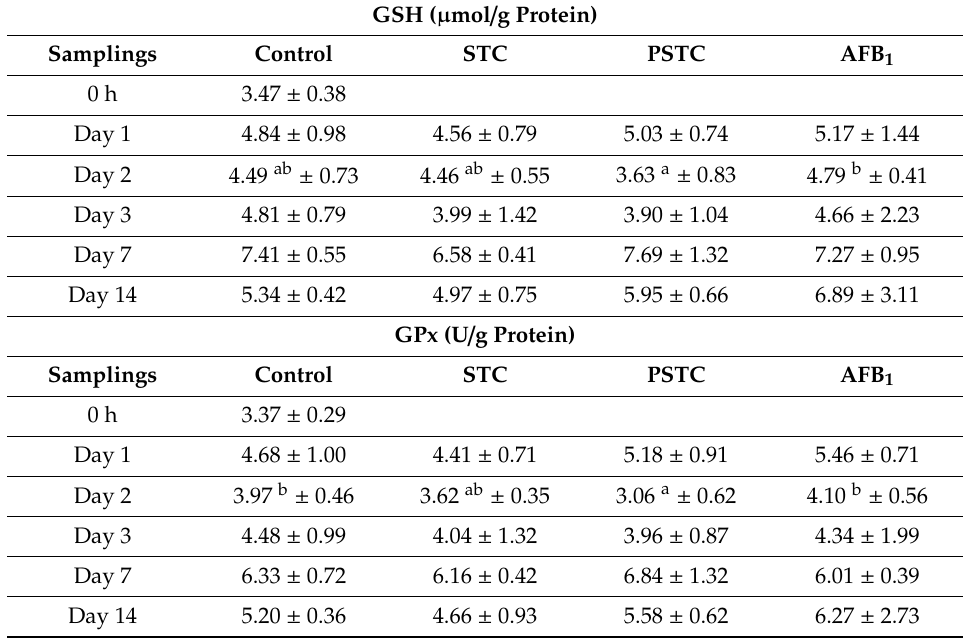
Table 5. E ff ect of sterigmatocystin or aflatoxin on reduced glutathione (GSH) concentration